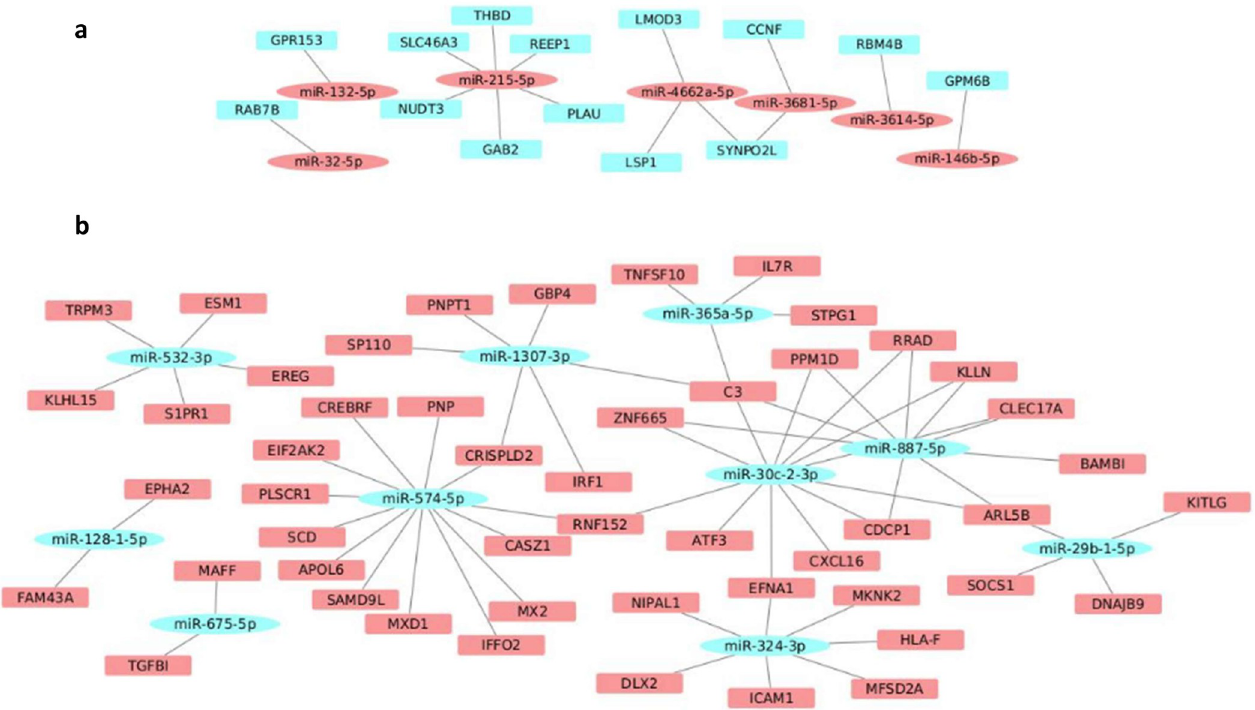
Fig 5. Modulation of miRNAs following in vitro ZIKV infection in human myoblasts. ( A ) Network formed by upregulated miRNAs (red ellipses) and their respective targets downregulated (blue rectangles) in ZIKV-infected myoblasts. ( B ) Network formed by downregulated miRNAs (blue ellipses) and their respective targets downregulated (red rectangles) in ZIKV-infected myoblasts. The whole list of differentially expressed miRNAs can be seen in S2 Table.